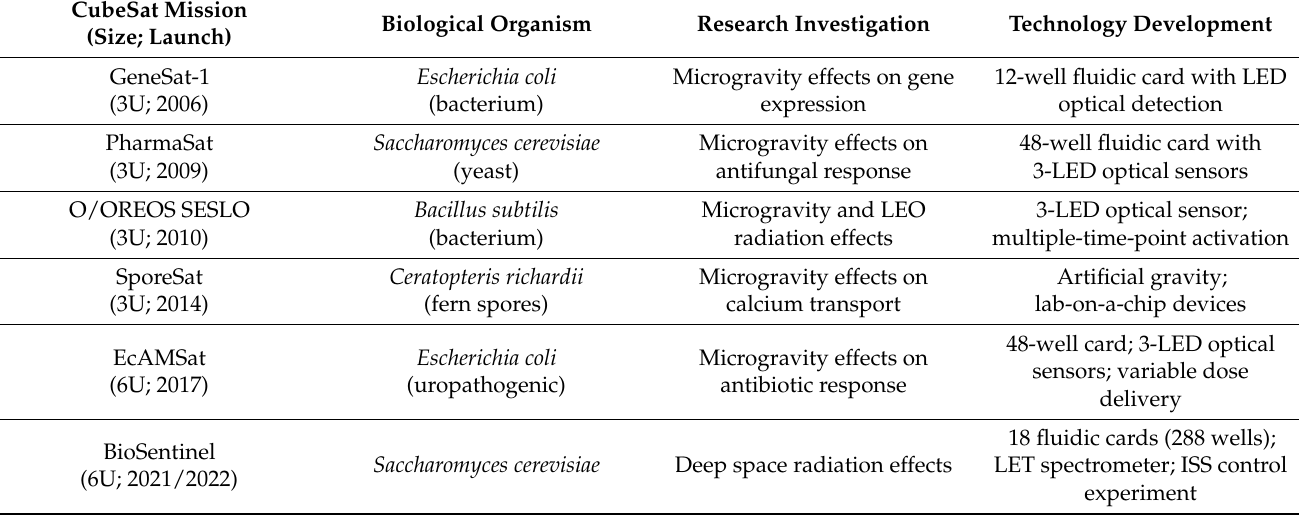
Table 2. NASA’s biological CubeSat